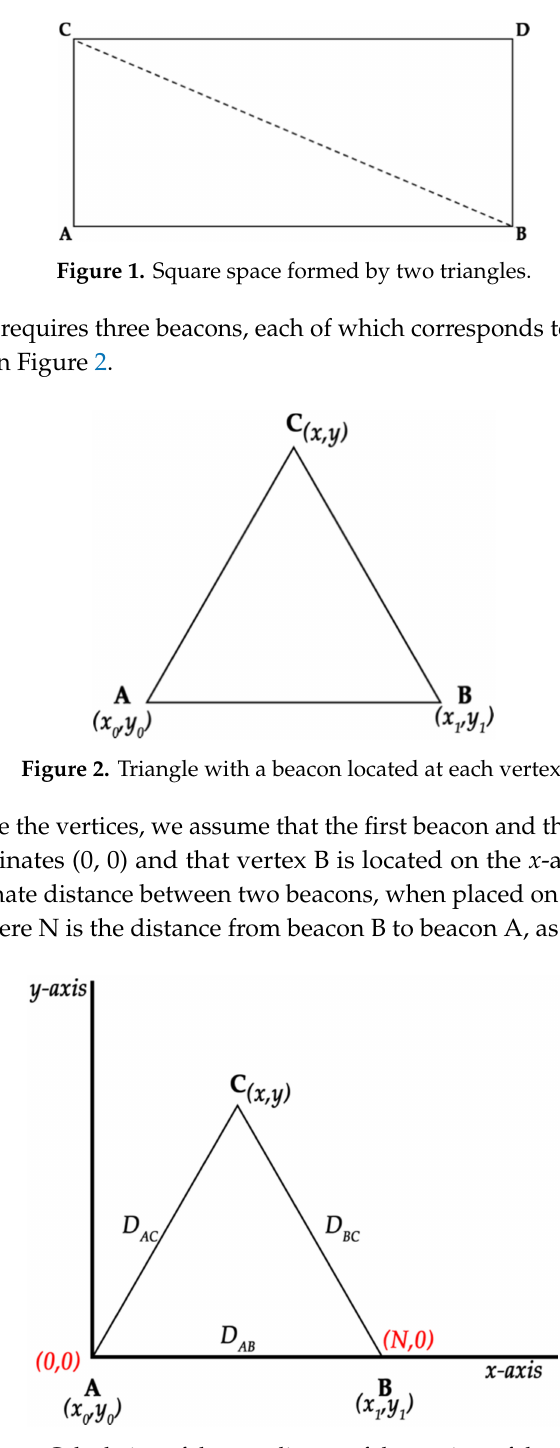
Figure 3. Calculation of the coordinates of the vertices of the